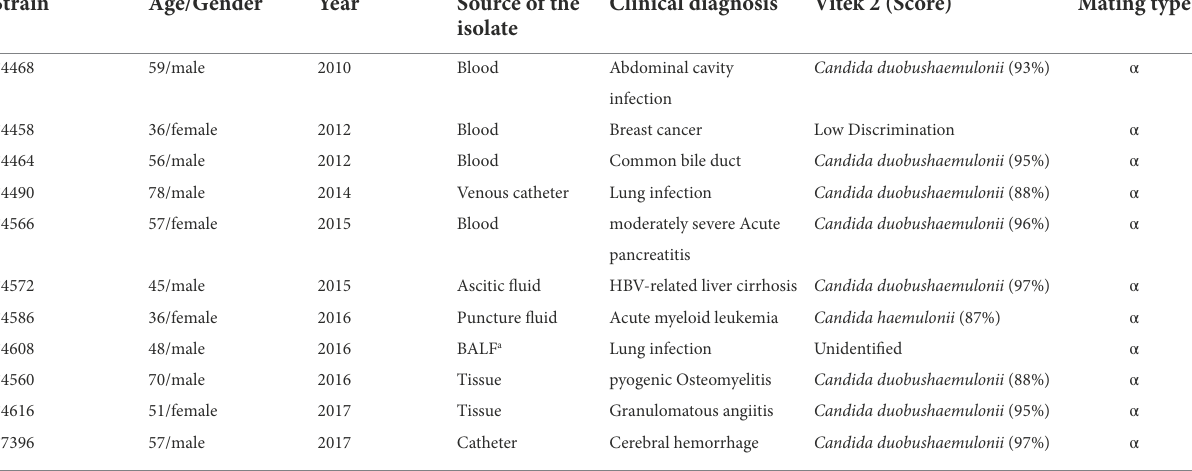
TABLE 1 List of isolates included in the